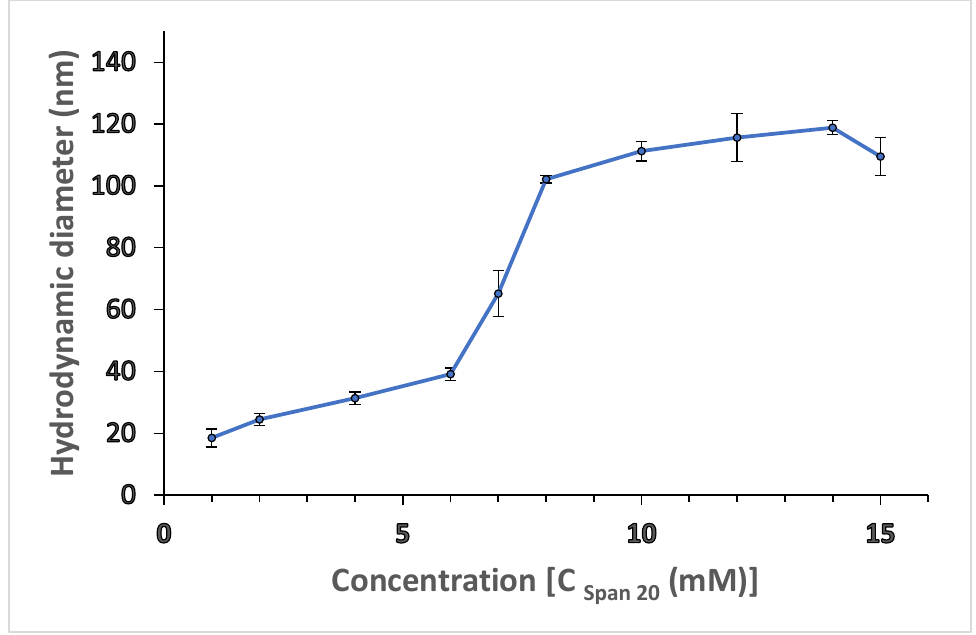
Figure 1. Apparent hydrodynamic diameter of aggregates formed by SPAN 20 in hexane, measured by DLS. Error bars are standard deviations.